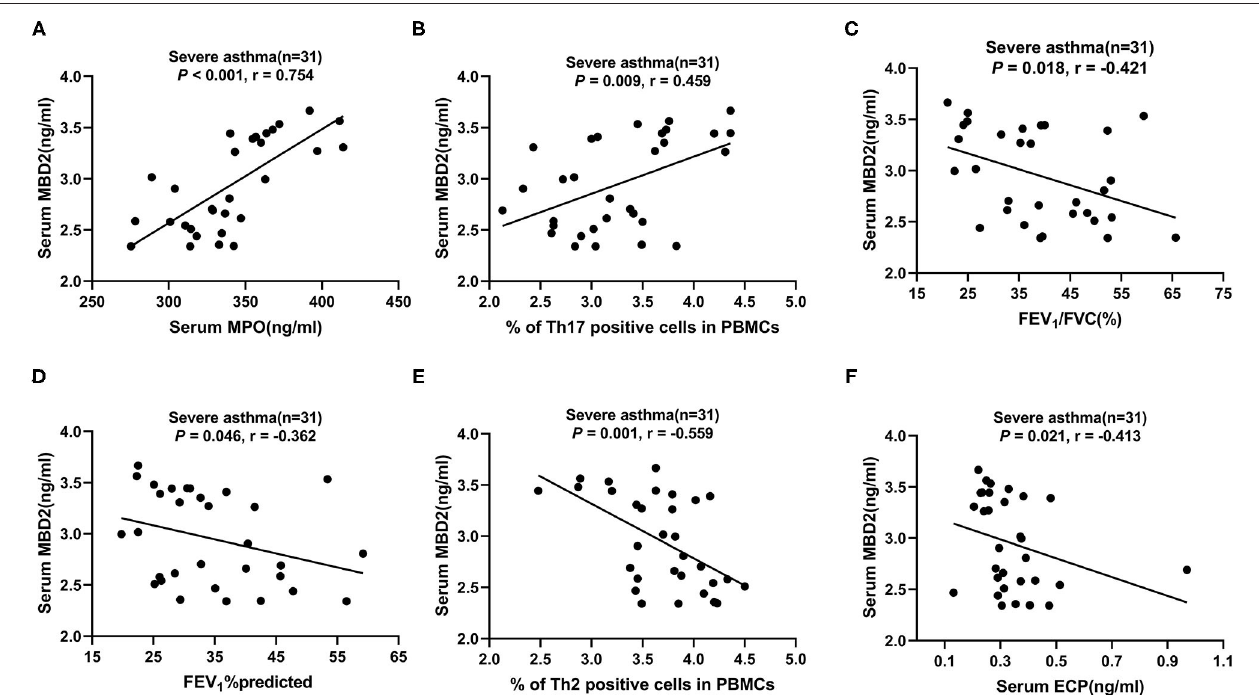
FIGURE 4 | Correlation of serum MBD2 levels with clinical characteristics and pulmonary function test results in patients with severe asthma. (A–F) The correlation between serum MBD2 levels and serum MPO (A) , Th17 cells in PBMCs (B) , FEV 1 /FVC (C) , FEV 1 %predicted (D) , Th2 cells in PBMCs (E) , and serum ECP (F) . Correlations were determined by Spearman’s rank correlation test. P < 0.05 was considered statistically significant. FEV 1 , forced expiratory volume in 1s; FVC, forced vital capacity; MBD2, methyl-CpG binding domain protein 2; ECP, eosinophilic cationic protein; MPO, myeloperoxidase; Th2, T-helper cell type 2; Th17, T-helper cell type 17; r, correlation